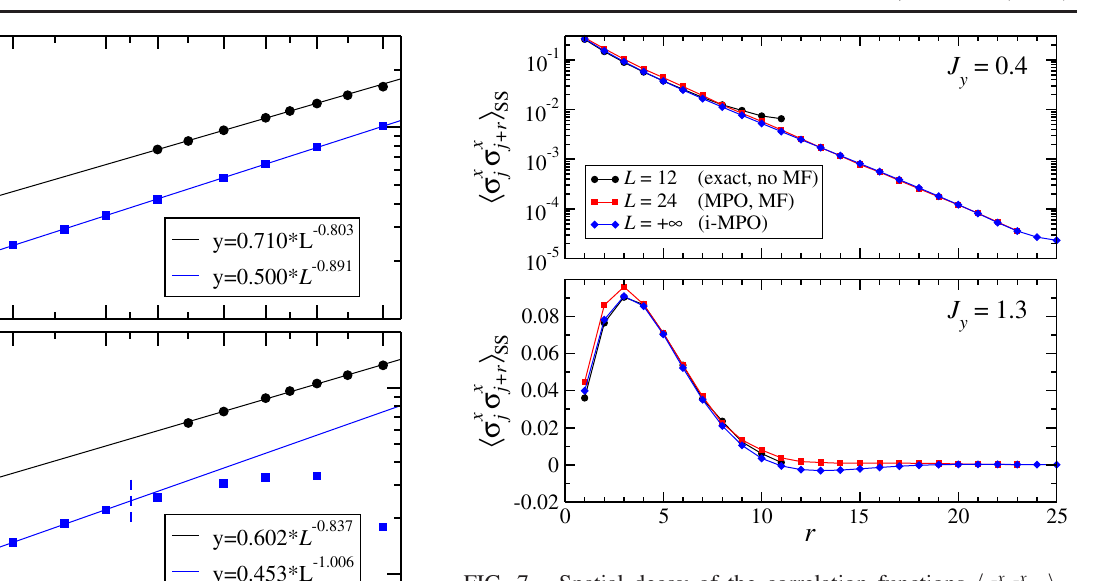
i SS þ r 1 . 3 y ¼